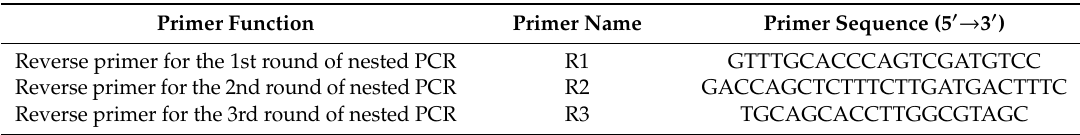
Table 1. Gene-specific primers designed for putative snail aPKC mRNA